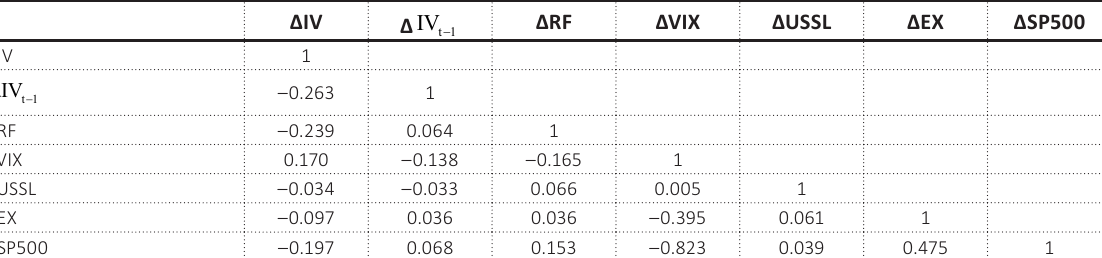
Table 3. Correlation among model